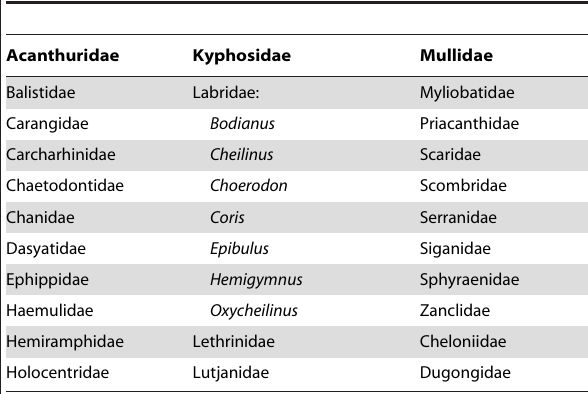
Table 1. List of families identified and counted during image analysis.